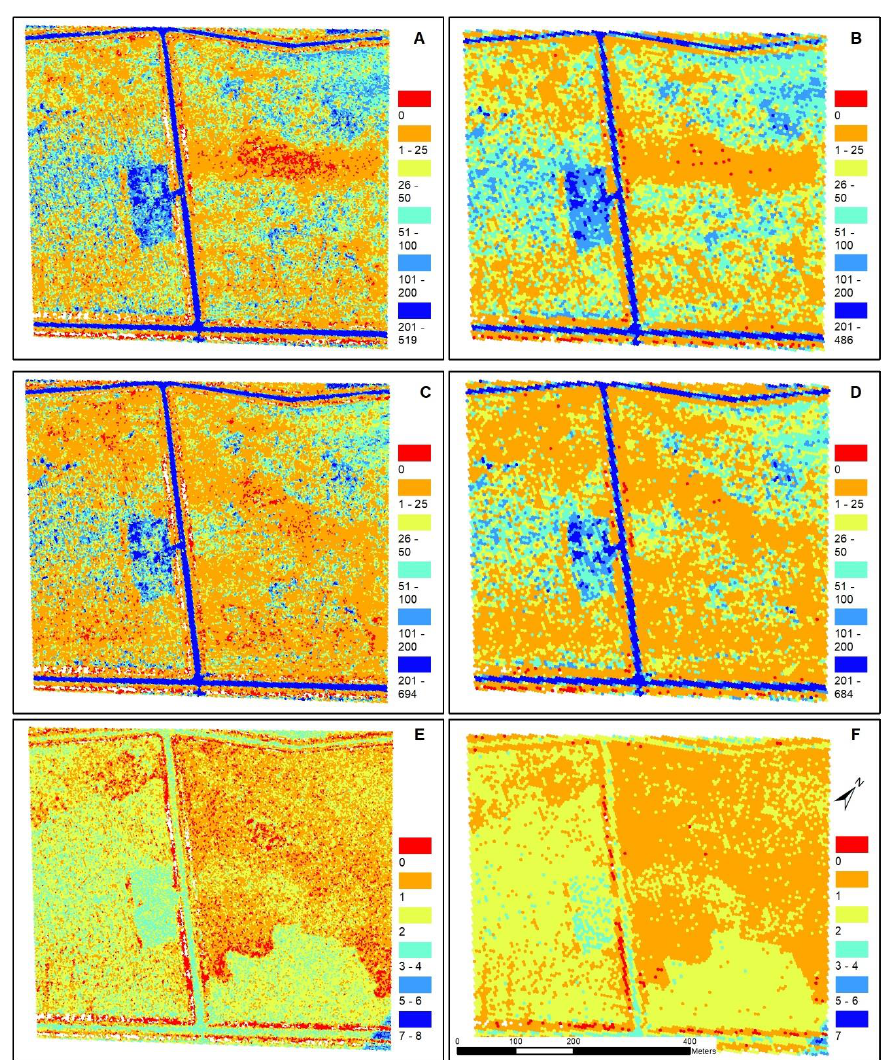
Figure 4. Ground point density (points/m 2 ) of two LiDAR UAS sensors, the Quanergy M8 and Velodyne HDL-32E, and North Carolina Quality Level 2 (QL2) LiDAR data: ( A ) Quanergy at 5 m 2 tessellation, ( B ) Quanergy at 25 m 2 tessellation, ( C ) Velodyne at 5 m 2 tessellation, ( D ) Velodyne at 25 m 2 tessellation, ( E ) QL2 at 5 m 2 tessellation, and ( F ) QL2 at 25 m 2